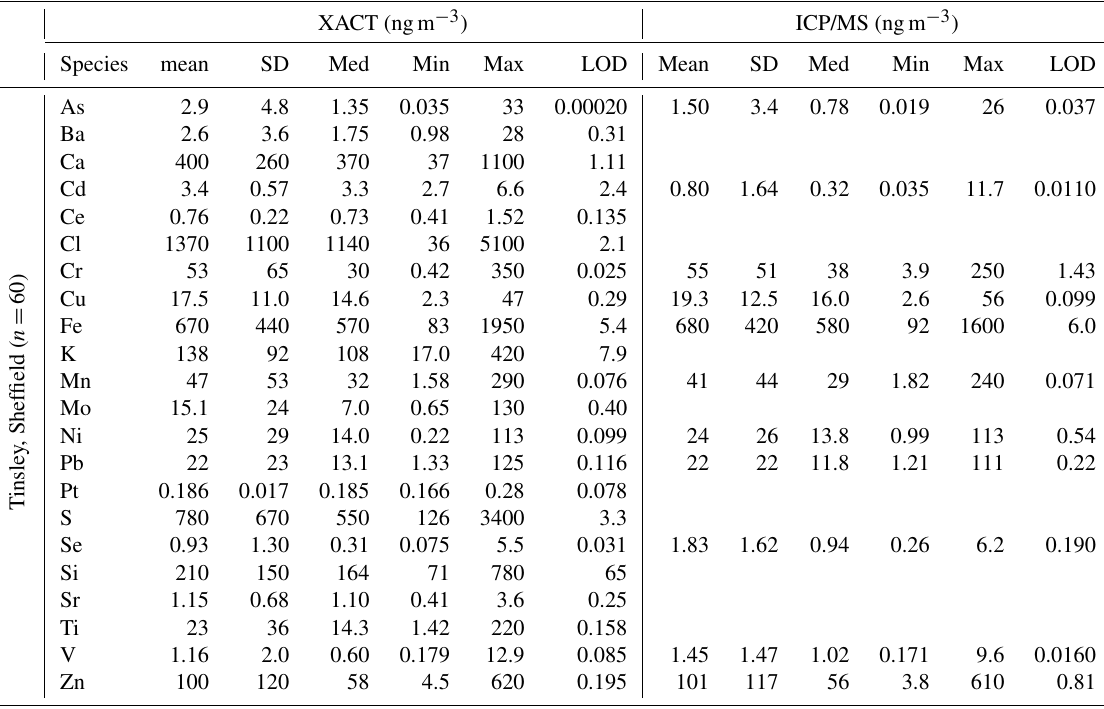
Table 5. Overview of Tinsley, Sheffield measurements by XACT and ICP-MS (ng m − 3 ).